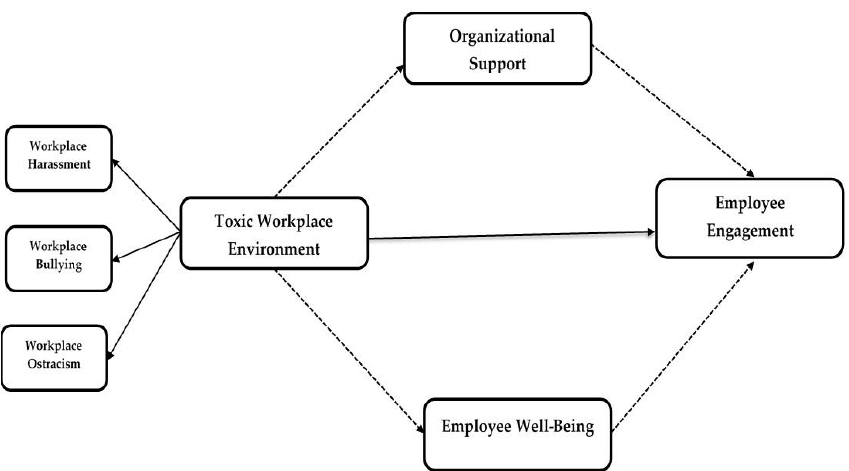
Figure 1. Research model. Dashed arrows indicate indirect relationships, and solid arrows indicate direct relationships.